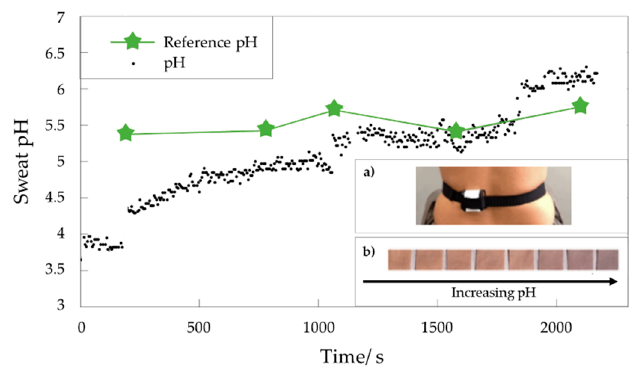
Figure 3. Comparison of sweat pH measurements carried out by wearable sensors and a reference pH meter as a function of time. In insets, the on-body position of the device during physical activities ( a ) and colour changing as a function of increasing pH values ( b ). Adapted with permission from [56] Copyright (2016) American Chemical Society.